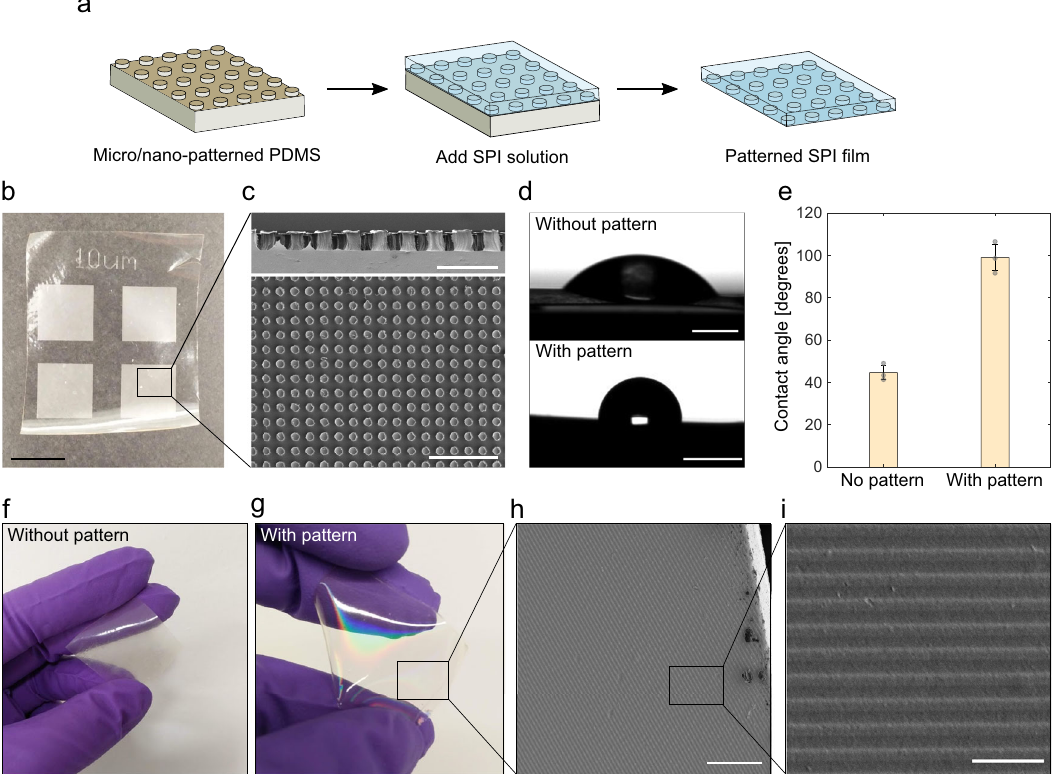
Fig. 7 Micro- and nanopatterning of plant protein fi lm. a Schematic illustration of the soft lithography process to pattern SPI fi lm. b Optical image of the micro-patterned fi lm. Scale bar represents 5 mm. c SEM image of the side view (top) and top view (bottom) of patterned micropillars. Scale bars represent 25 μ m (top) and 100 μ m (bottom). d Optical images of a water droplet on the fi lm without (top) and with (bottom) micropillars. Scale bars represent 1 mm. e Water contact angles of the fi lms, showing an increase of hydrophobicity in the patterned fi lm. The indicated error bars are the s.d. of the average of three independent measurements. f , g Optical image of non-patterned ( f ) and nano-patterned photonic fi lm ( g ). h , i SEM image of the nano-patterned fi lm. Scale bars represent 20 μ m ( h ) and 2 μ m ( i